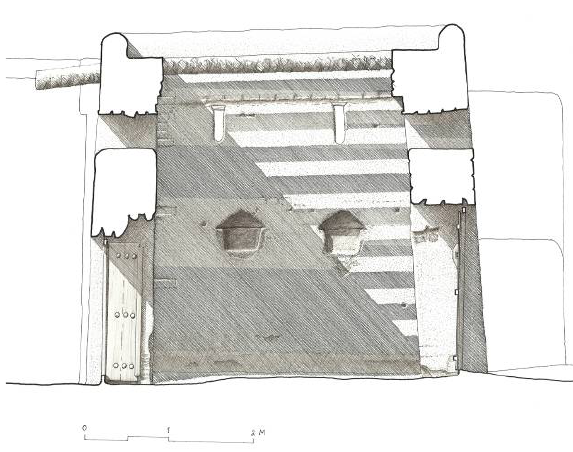
Figure 3. A sectional elevation of a room next to Qattara Souk in Al Qattara Oasis (original 1:25) produced by Finnish architect Markku Matila